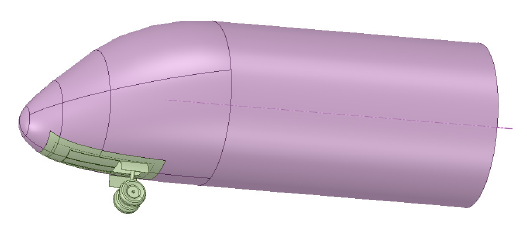
( c ) Deployed configuration. Figure 2. NLG: simplified geometric model.